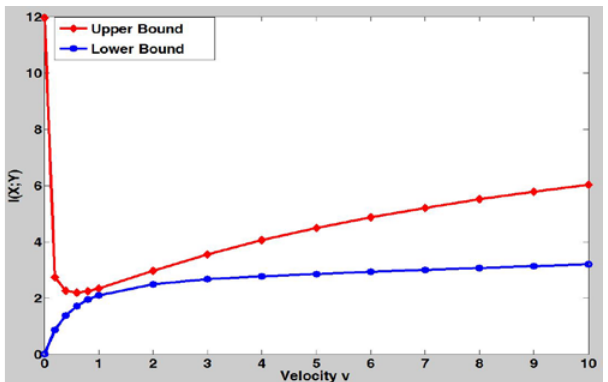
Figure 4: Upper and lower capacity bounds for the molecular relay channel as a function of drift velocity. The delay constraint has been set to m = 2, 1, 1.5 for C TR , C TM , C MR , and the channel parameter λ is assumed to be 0.25